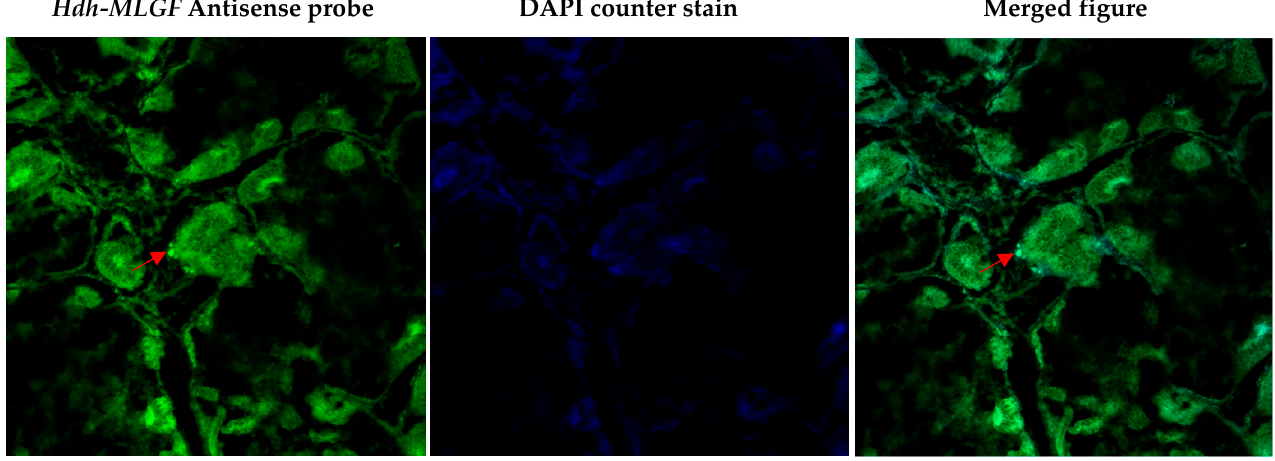
Figure 9. Microscopic (confocal laser scanning microscope) observation of Hdh-MLGF in digestive gland tissue of adult Pacific abalone using FISH.